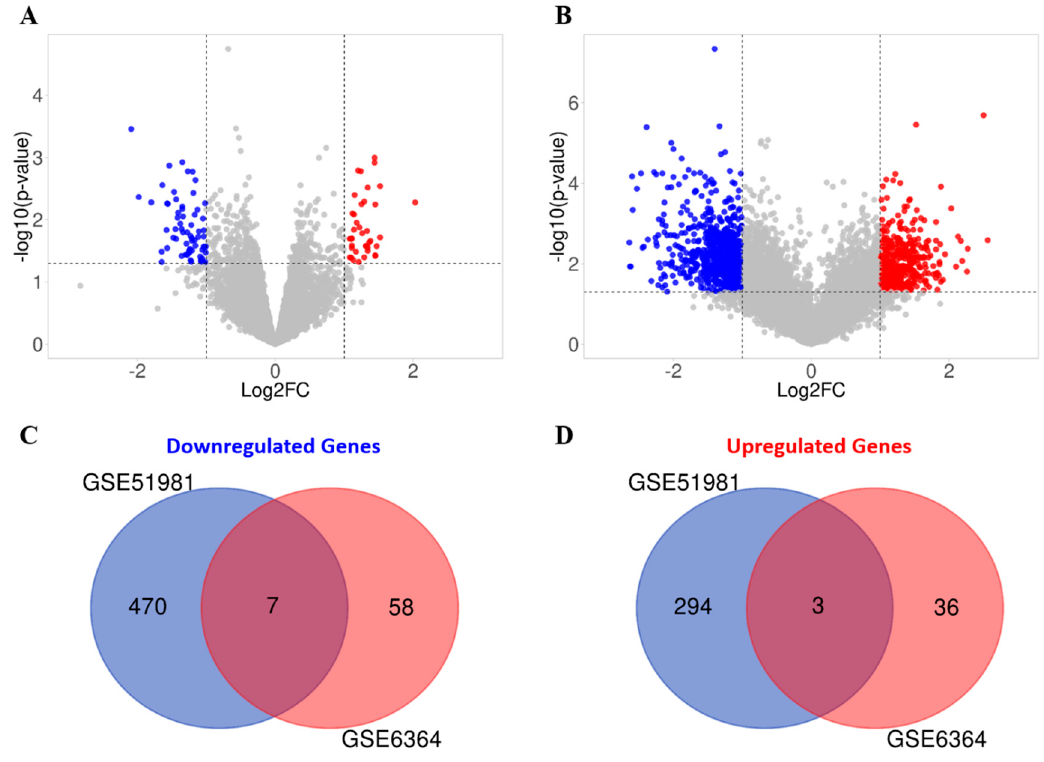
Figure 8. Di ff erentially expressed genes (DEGs) in mid-secretory endometrial samples from women with endometriosis, compared with healthy controls from the ( A ) GSE6364 and ( B ) GSE51981 datasets, shown as Volcano plots. Cut-o ff criteria: | log2FC > 1 | and p < 0.05. Red denotes upregulation, and blue denotes downregulation. ( C ) Venn diagram demonstrating upregulated genes in both GSE51981 (blue) and GSE6364 (red) and the common genes between both datasets (purple). ( D ) Venn diagram demonstrating downregulated genes in both GSE51981 (blue) and GSE6364 (red) and the common genes between both datasets